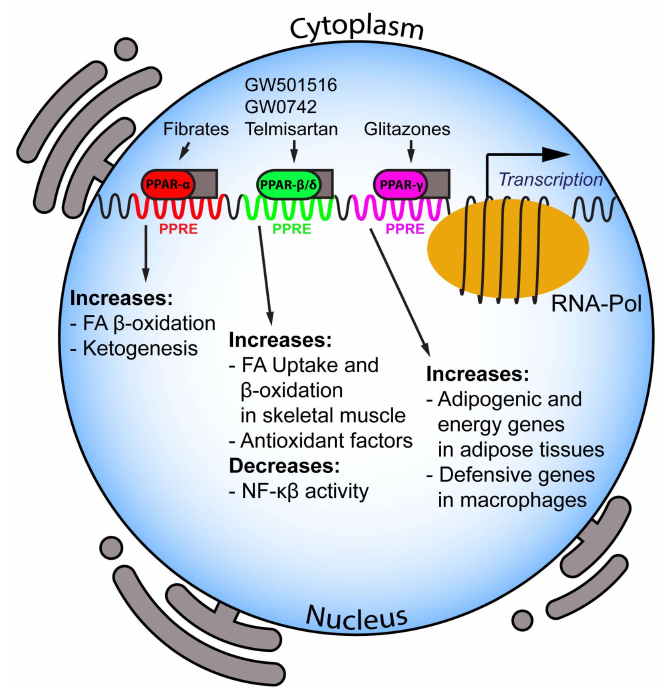
Figure 1. Major roles of different peroxisome proliferator-activated receptors (PPARs) isotypes. PPARs are a class of nuclear transcription factors that heterodimerize with retinoid X receptor (RXR, gray boxes) upon physiological (i.e., fatty acids) and synthetic activation (i.e., fibrates, glitazones etc.) to regulate the specific indicated pathways. FA, Fatty Acids; NF κ B, Nuclear Factor- κ